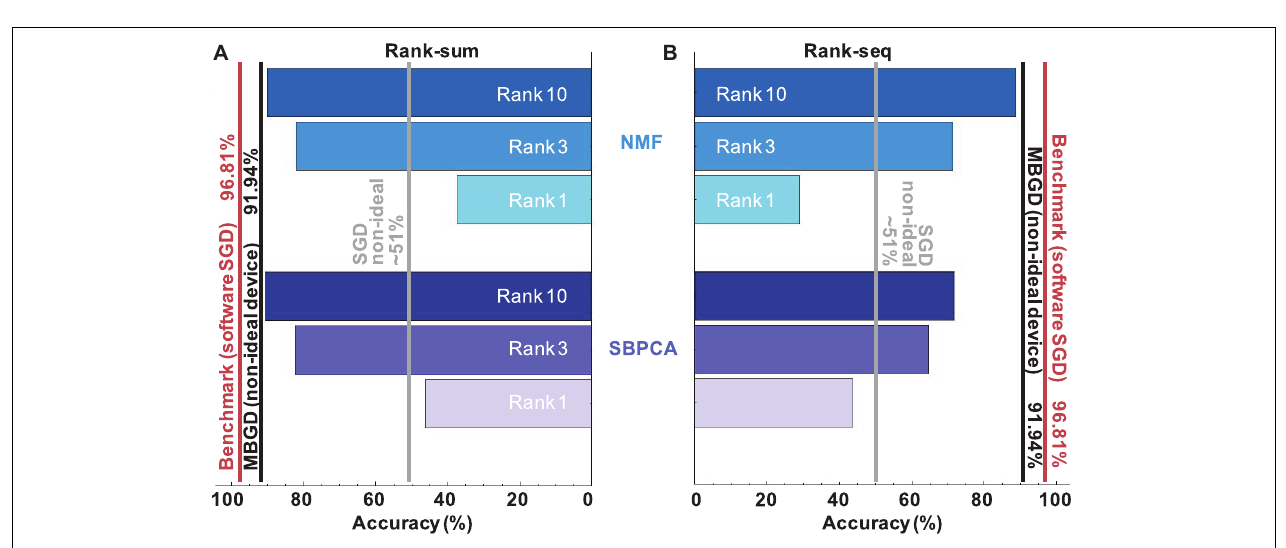
FIGURE 10 | Comparison of streaming batch PCA and NMF results for rank-sum and rank-seq for a multi-layer perceptron with non-ideal memristive weights at different ranks and batch sizes. The results show that the streaming batch PCA using rank-sum slightly outperforms NMF rank-sum and can approximate very well the MBGD results at high ranks. By comparison, NMF rank-seq significantly outperforms streaming batch PCA rank-seq for higher ranks (e.g., 3 and 10) and can approximate well the MBGD results. For all these experiments, the rounding method is stochastic, batch size = 4096 and block size =